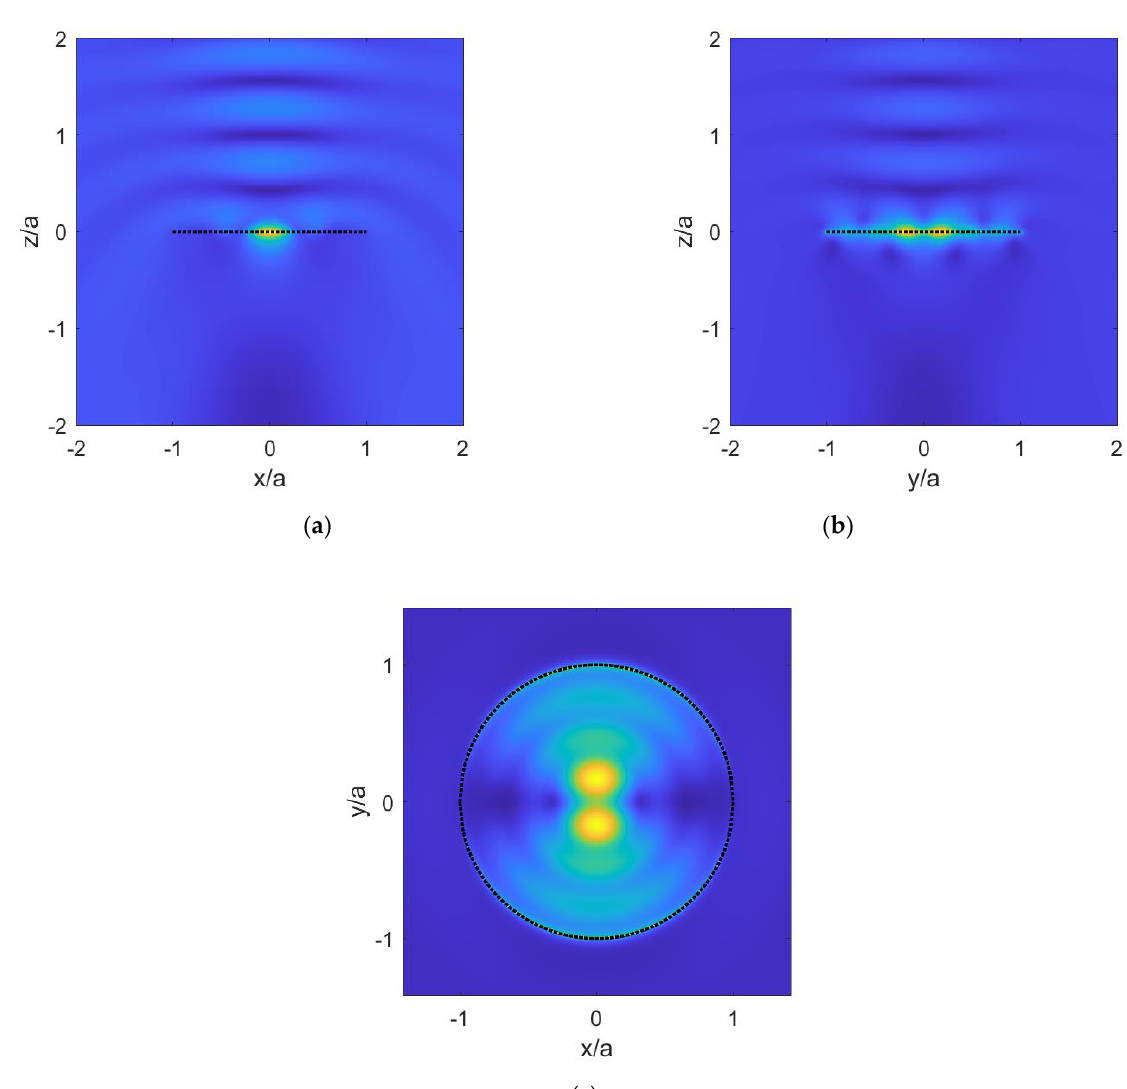
Figure 6. Near E-field behavior in the Cartesian coordinate planes of the graphene disk with a = 50 µ m, T = 300 K, t relax = 1 ps, µ c = 1 eV at the resonance frequency f = 5.662107 THz, when a plane wave orthogonally impinges onto the disk with E 0 = E 0 ˆ y . ( a ) Near E-field in the xz plane; ( b ) Near E-field in the yz plane; ( c ) Near E-field in the xy